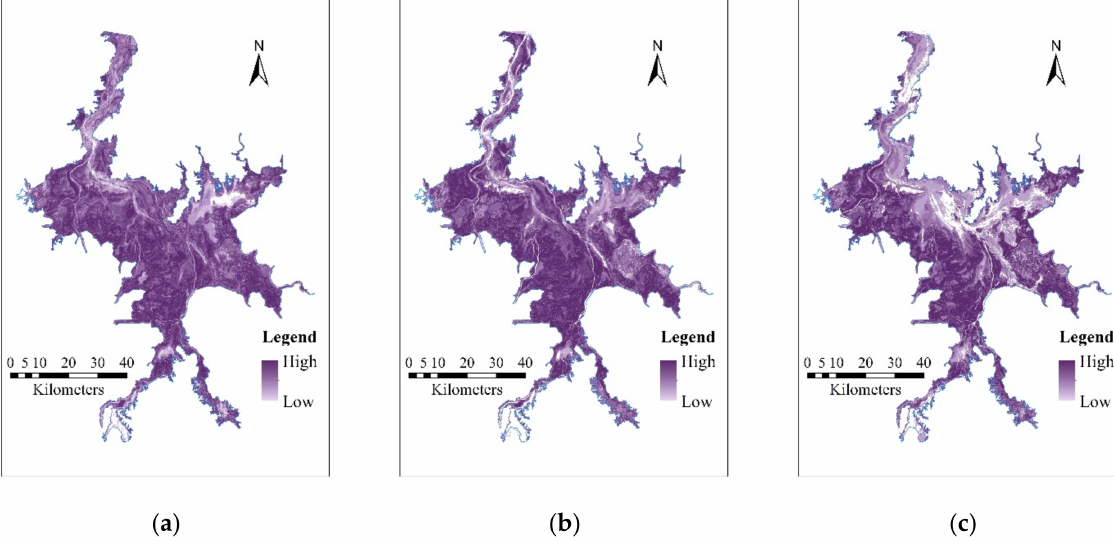
Figure 7. Stabilities of crane habitats in the Poyang Lake wetland under different hydrological conditions: ( a ) EL, extremely low level; ( b ) LL, low level; ( c ) AL, average level. Higher values indicate stronger stability of the crane